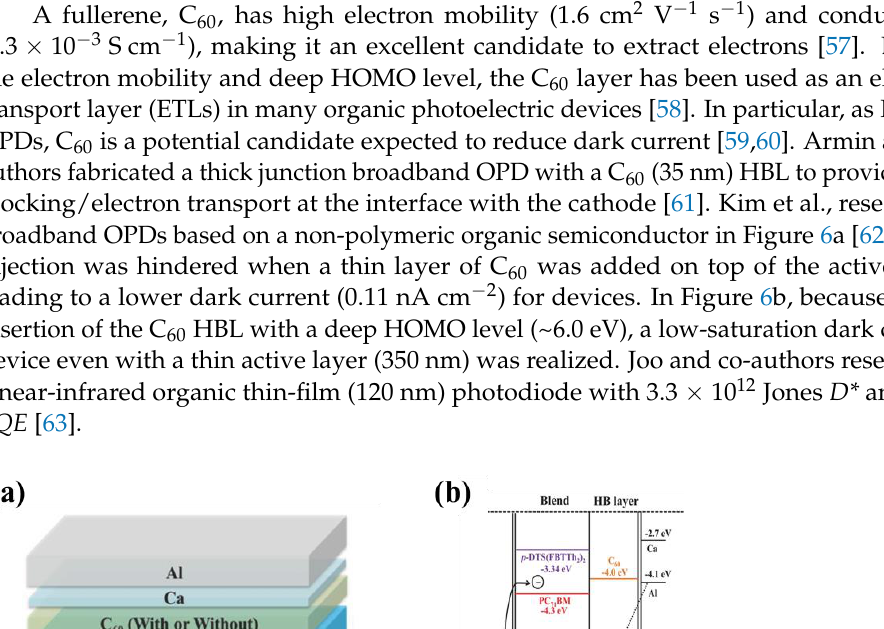
Figure 5. ( a ) Device structure of OPDs with Bphen as the HBL; ( b ) Calculated D* values of OPDs based on various ratios ternary blends system. (Reproduced with permission from [55]. Springer Publishing, 2019). ( c ) The device configuration, molecular structure, and energy level of the respective materials; ( d ) Current density–voltage characteristics (dark and illumination conditions) of OPD with various thicknesses. (Reproduced with permission from [56]. WILEY Publishing, 2020).